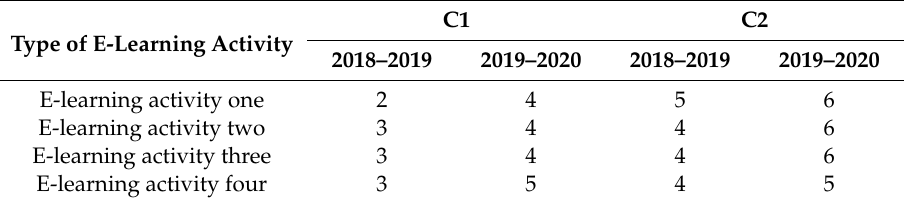
Table 2. Distribution of the e-learning activities between students (groups and treatments). C1 Type of E-Learning Activity